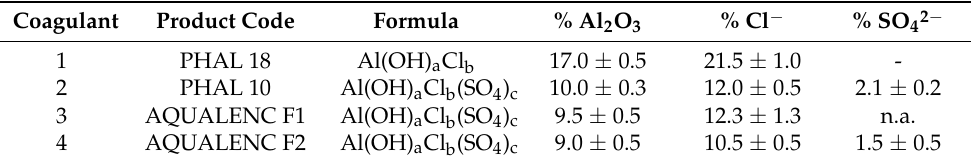
Table 3. Features of the different coagulants used in this study (Feralco Iberia